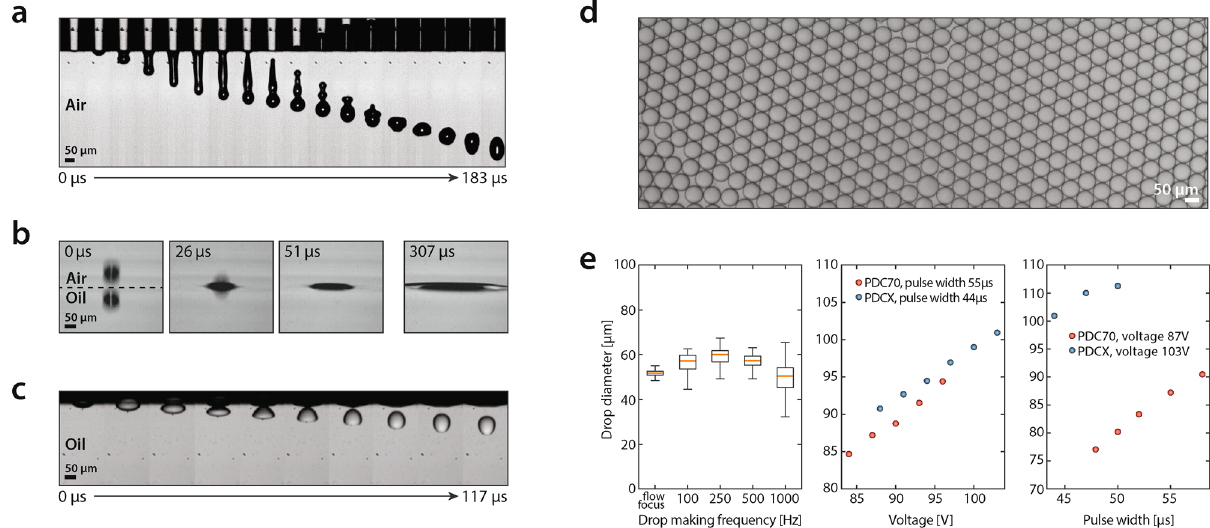
Figure 2. Drop-in-air printing into oil is rapid, reliable, and tunable. ( a ) Time-lapse imagery of the droplet being ejected from the capillary tube into air by acoustic waves. ( b ) Impact of droplet into the oil layer. ( c ) Behavior of the droplet once it pierces the oil layer. ( d ) Micrograph of droplets generated at 300 Hz. ( e ) Droplet size distribution as a function of acoustic wave frequency (left), voltage (center), and pulse width